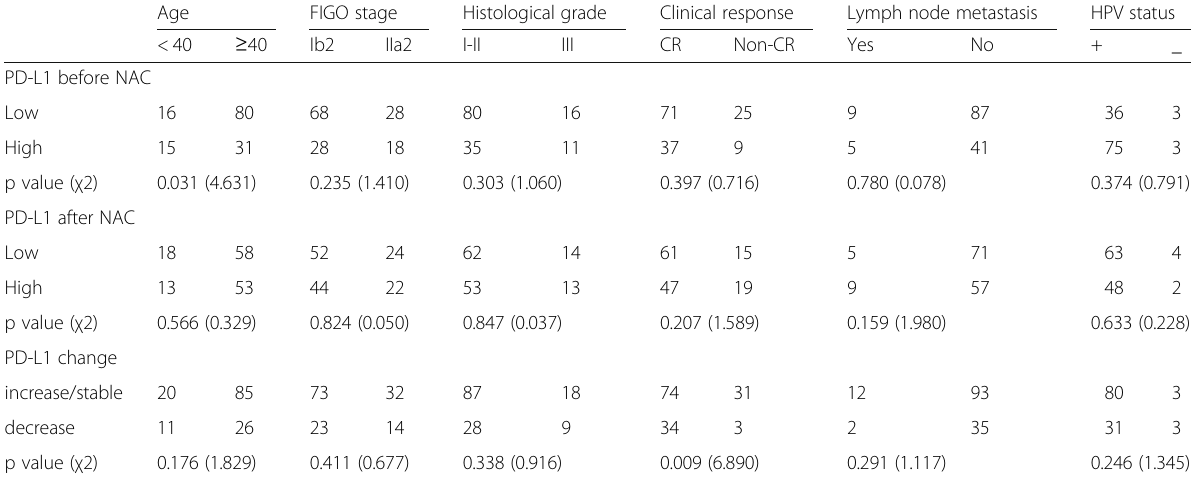
Table 1 Correlations between clinicopathological characteristics and PD-L1 expression before NAC, after NAC, as well as the change of PD-L1 Age FIGO stage Histological grade Clinical response Lymph node metastasis